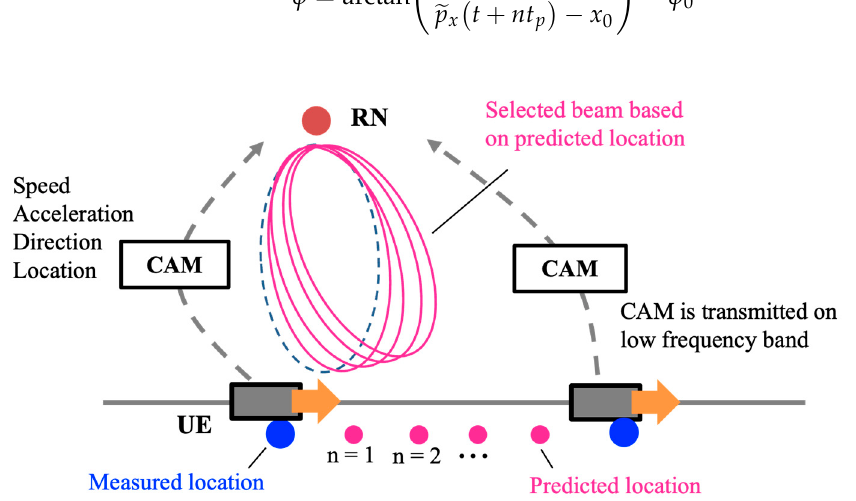
Figure 4. Relay-beam tracking utilizing UE location, speed, acceleration, and direction contained in